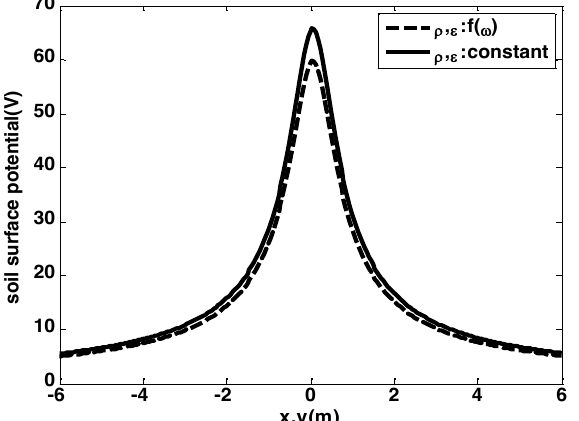
Figure 17: Induced voltage on the soil surface of grounding grid from example 1.